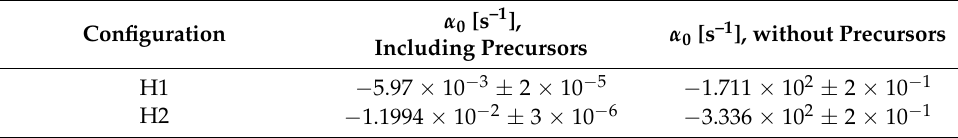
Table 19. Fundamental eigenvalues α 0 for H1 and H2 configurations of the CROCUS